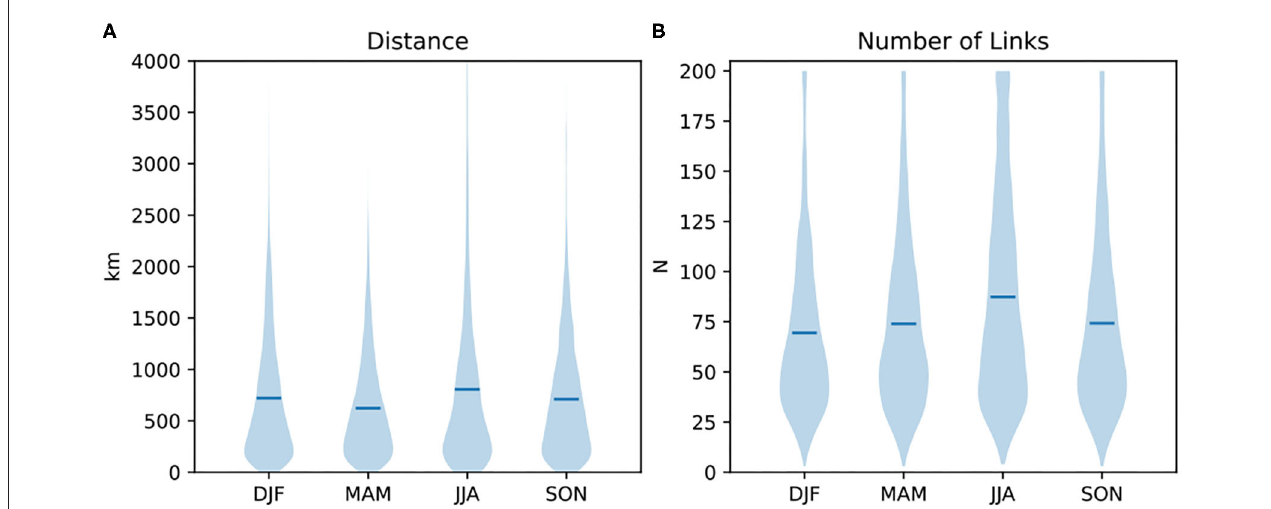
FIGURE 2 | Distribution of precipitation chain properties for different seasons. Both (A) average distance (km) and (B) average chain length in grid cells are longest in summer. Horizontal lines indicate mean values.